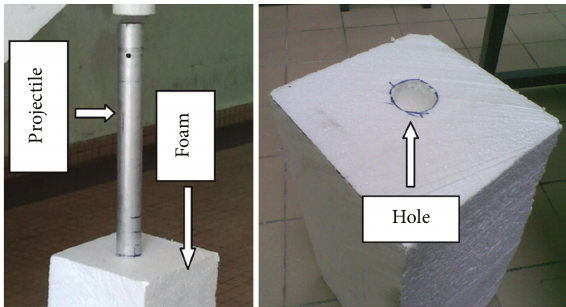
Figure 5: Localized damage on the specimen.